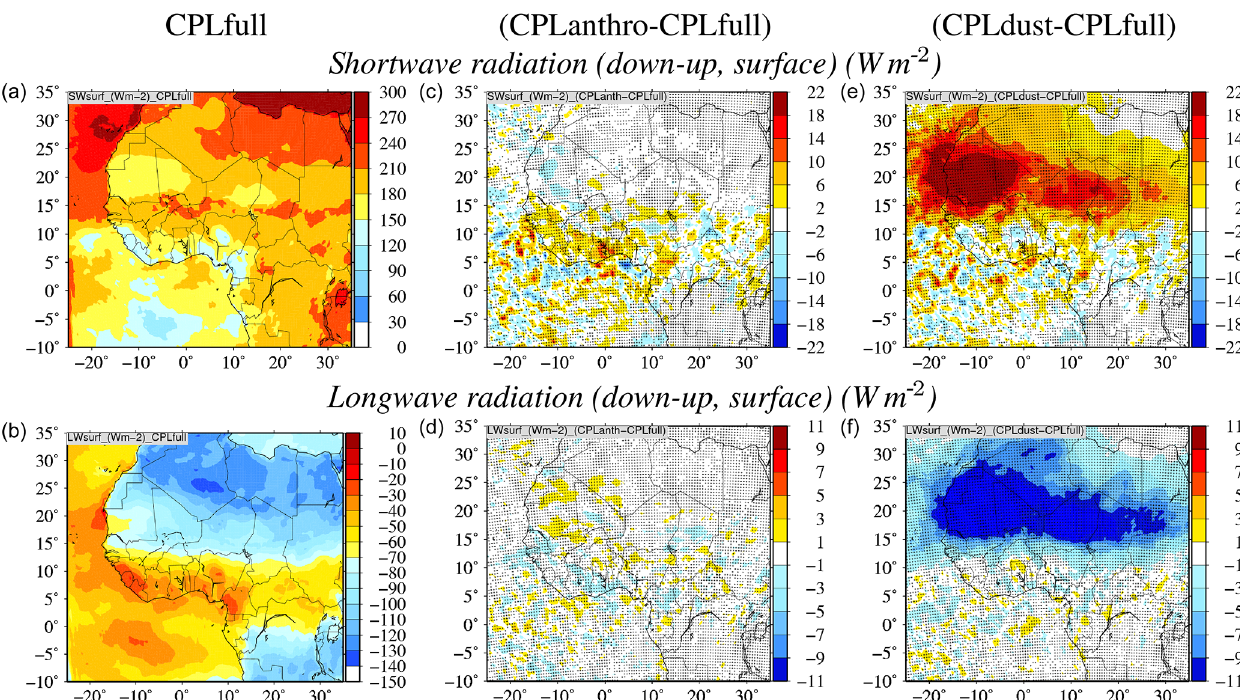
Figure 7. (a, b) Maps of the monthly mean shortwave radiation (down–up, surface) (Wm − 2 ) and longwave radiation (down–up, surface) (Wm − 2 ) for July 2016. (c, d) Maps of the monthly mean of daily averaged differences between CPLanthro and CPLfull for the same variables as the left row. (e, f) Maps of the monthly mean of daily averaged differences between CPLdust and CPLfull for the same variables as the left row. The tiny crosses on the map indicate where the difference was found to be